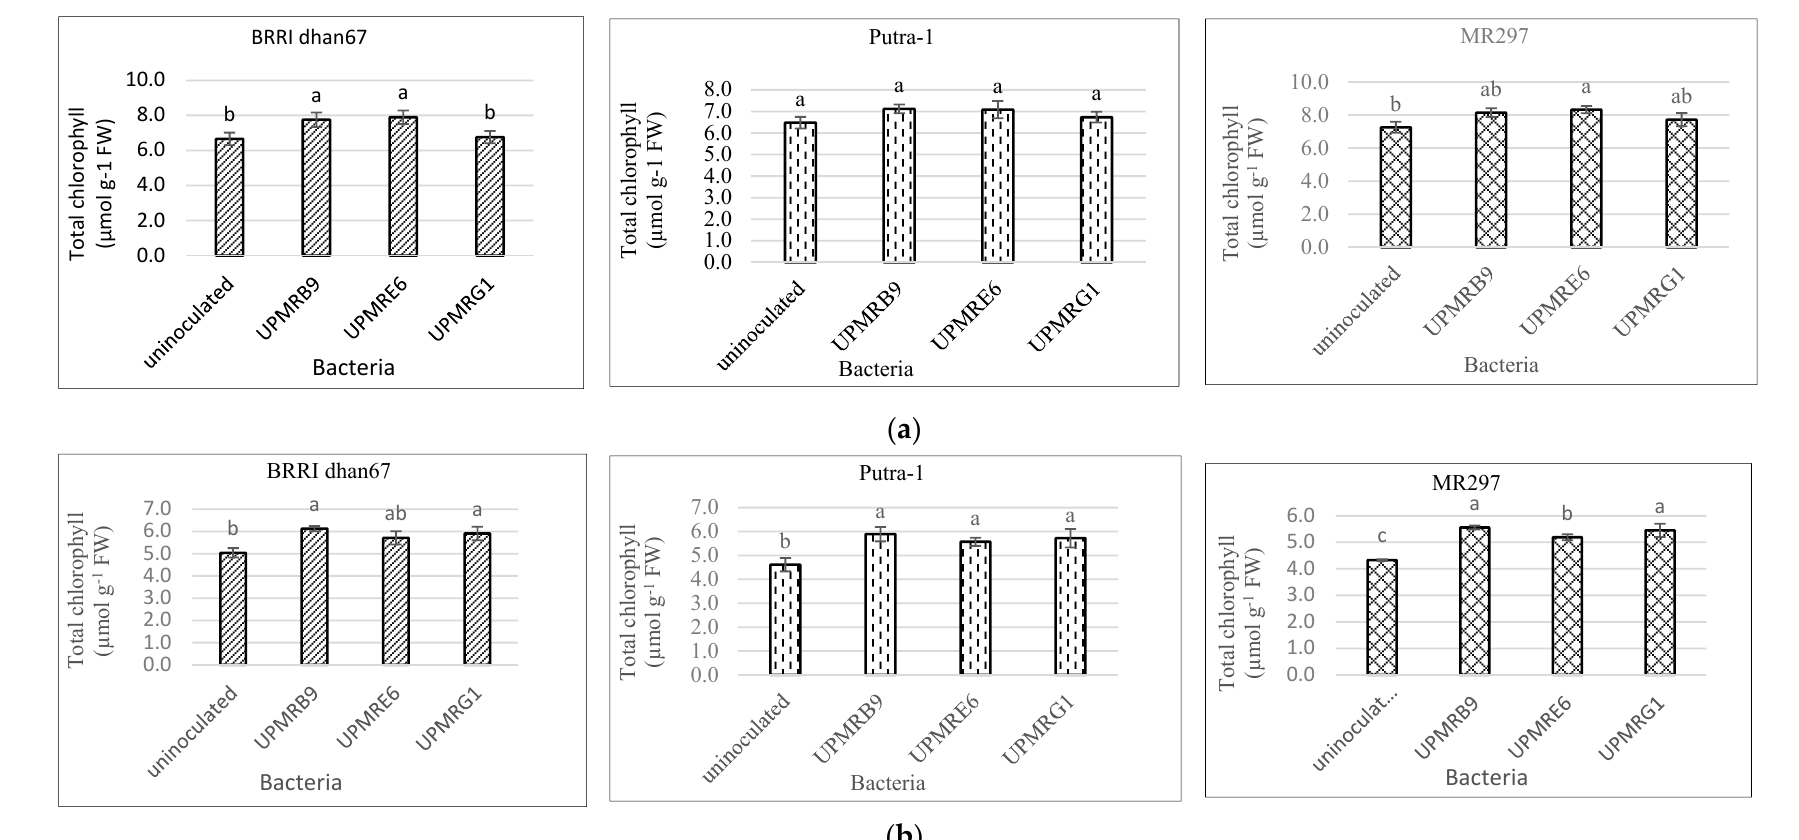
Figure 2. ( a ) Effect of bacterial inoculation on total chlorophyll content of three rice varieties under non-saline conditions. Means with the same letter in a column do not differ significantly using Tukey’s test at p > 0.05. ( b ) Effect of bacterial inoculation on total chlorophyll content of three rice varieties under saline conditions. Means with the same letter in a column do not differ significantly using Tukey’s test at p > 0.05.